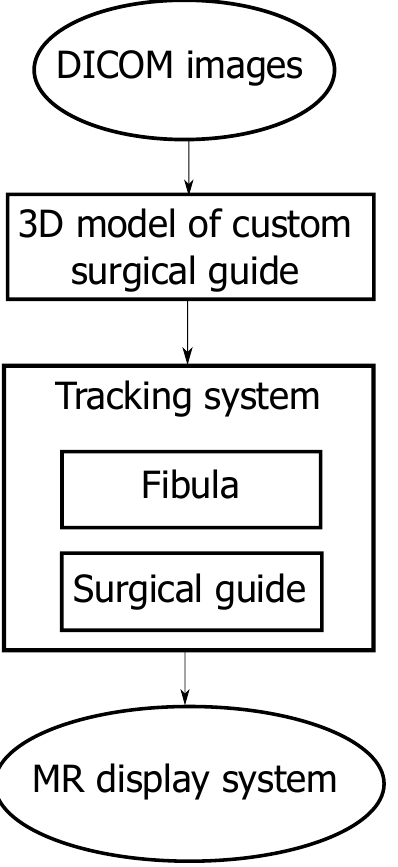
Figure 3. Workflow of the Mixed Reality application supporting surgical guides